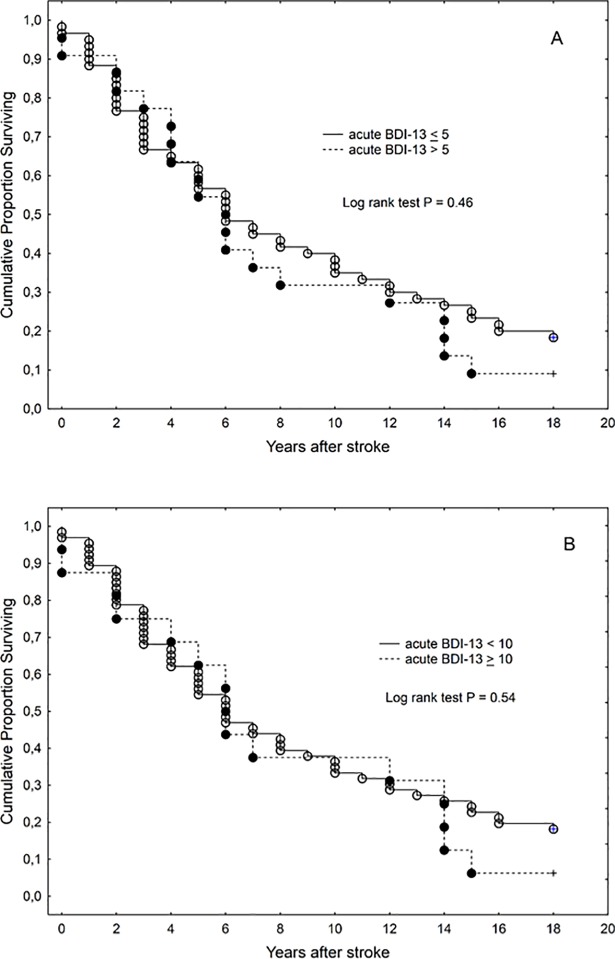
Kaplan-Meier graph of survival in those with Beck Depression Inventory score cutoff values of 5 (A) and 10 (B) in the acute stage (n = 82). BDI-13 = Beck Depression Inventory.